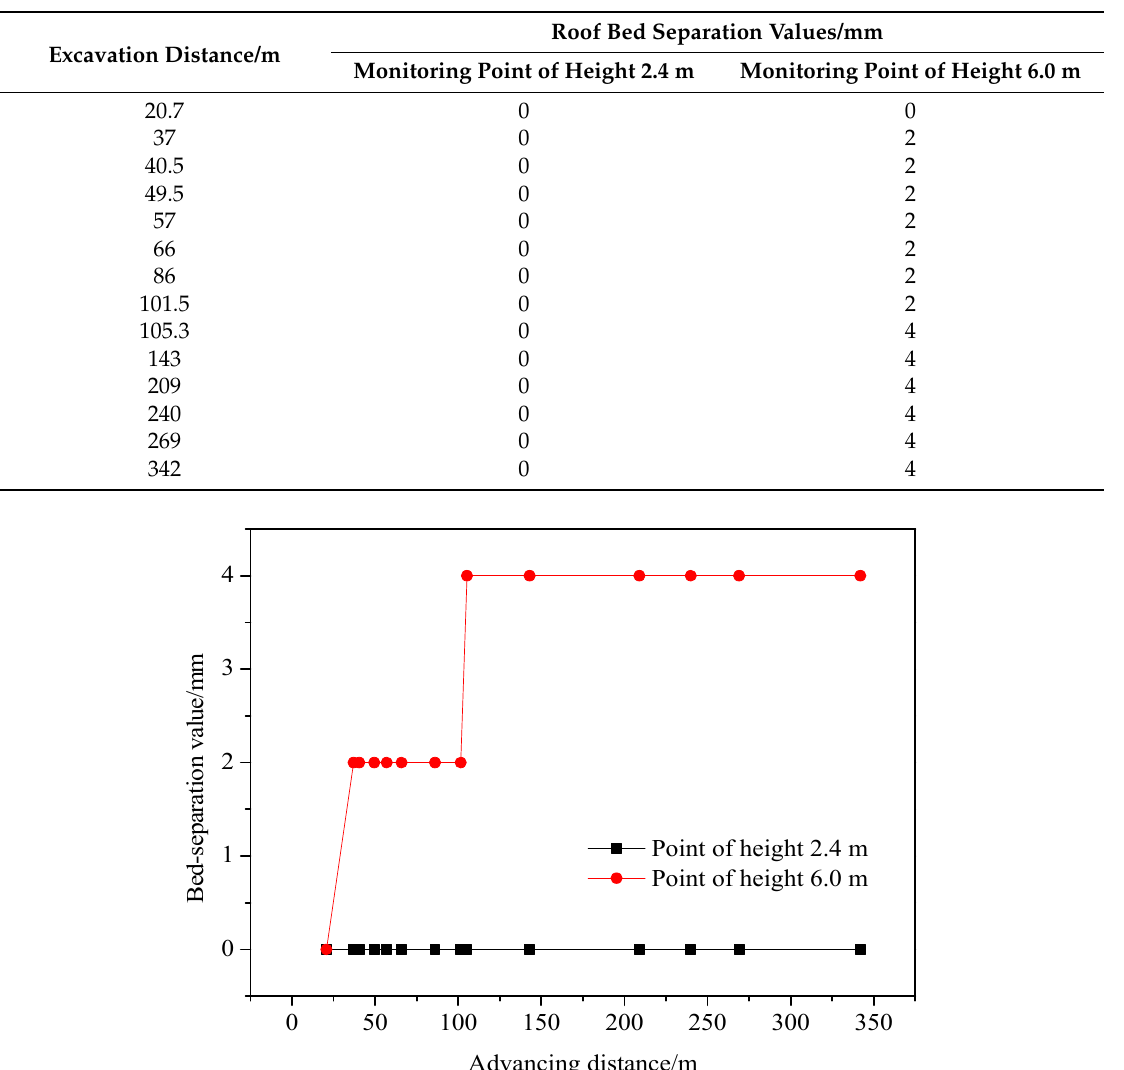
Table 6. Variation of the roof bed separation with the roadway excavation.